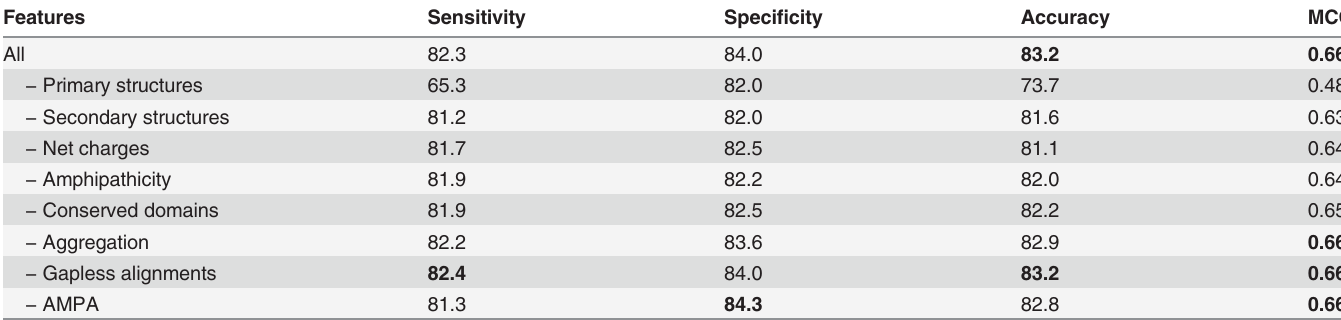
Table 2. Features ablation study of AMPcore on the low similarity dataset using 10-fold cross-validation.